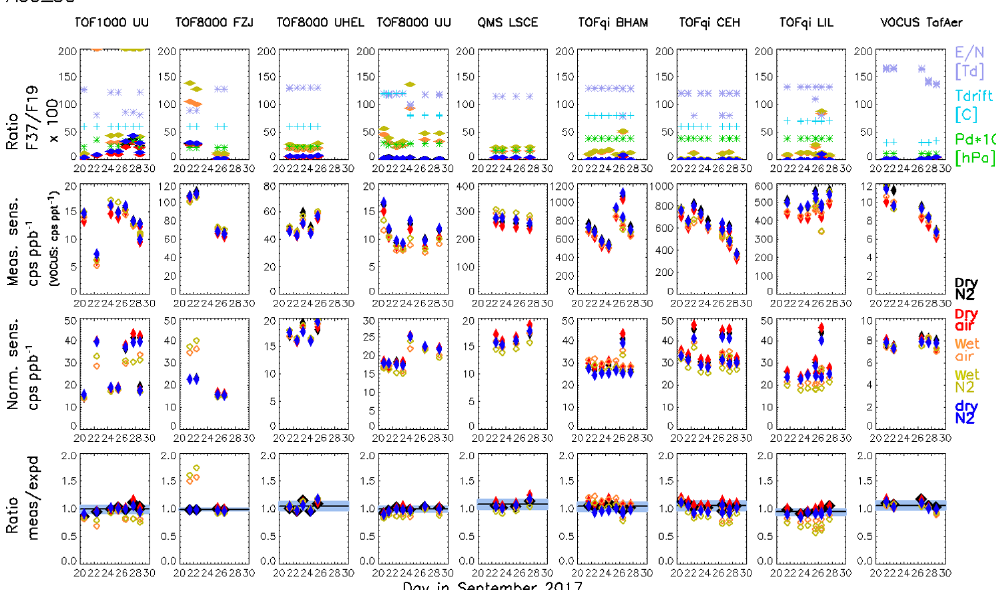
Figure 6. Summary for all measurements of acetone following our calibration protocol. Individual instruments are shown in the columns. The first-row panels show the ratio of primary ions H 2 OH 3 O + to H 3 O + (transmission corrected) as well as operating conditions of the instruments (temperature, degree, pressure in the drift tube, hPa, and E/N , Td, i.e. 10 17 Vm 2 ) . The second-row panels show the measured sensitivity of acetone for all instruments. The third-row panels show the normalized sensitivity, i.e. the measured sensitivity normalized to a transmission-corrected primary ion signal (sum of H 3 O + + H 2 OH 3 O + ) of 10 6 counts per second. The fourth-row charts show the ratio of the measured to expected sensitivity. The median ratio and the standard deviation of all ratios using dry carrier gas are plotted as black vertical line and grey shade, respectively. The colours and markers represent the different carrier gases. Humidified injections are depicted with open markers (orange and yellow-green for air and nitrogen, respectively); filled markers depict calibrations in dry carrier gas (black, red, and blue for nitrogen, air, and nitrogen, respectively).